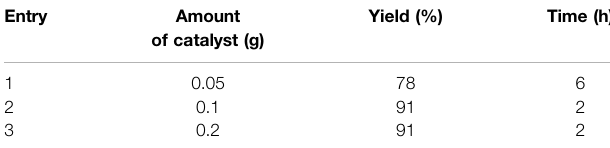
TABLE 2 | Investigation of the amount of catalyst used in the synthesis of 4a